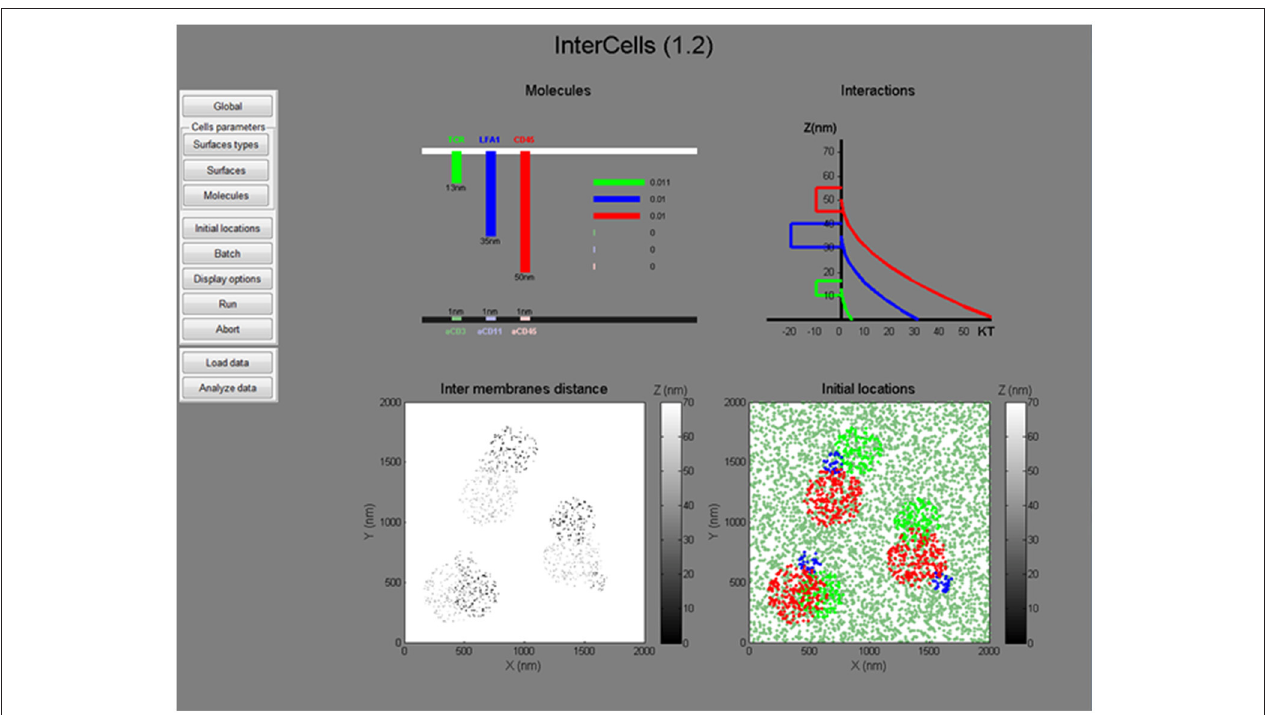
FIGURE 6 | The graphical user interface. A snapshot of the graphical user interface (GUI) of the simulation. The GUI includes dynamic menus for setting all simulation parameters and a live interface for presenting the simulated parameters (top) and initial conditions (bottom). All menus, parameters and operation instructions are provided in the User’s Manual in the Supplemental Information